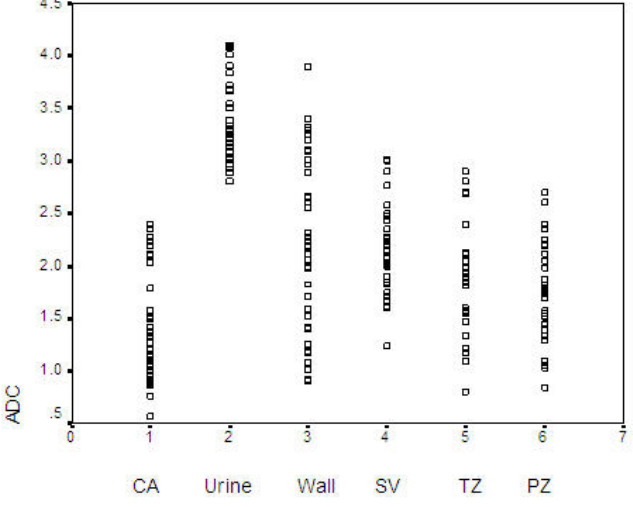
FIGURE 3. Scatter-plots of the ADCs of urinary bladder carcinomas (CA), urine, normal bladder wall (Wall), seminal vesicle (SV), transition zone (TZ) of the prostate, and the peripheral zone (PZ) of the